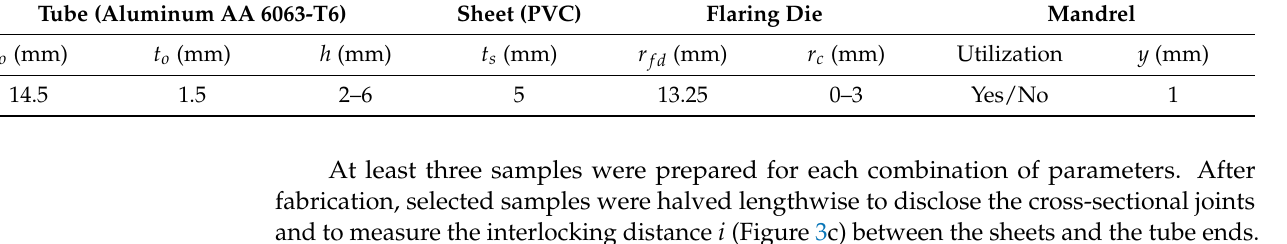
Table 2. Experimental work plan for the joining by tube flaring and sheet squeezing. Notation in accordance with Figure 3. Tube (Aluminum AA 6063-T6)